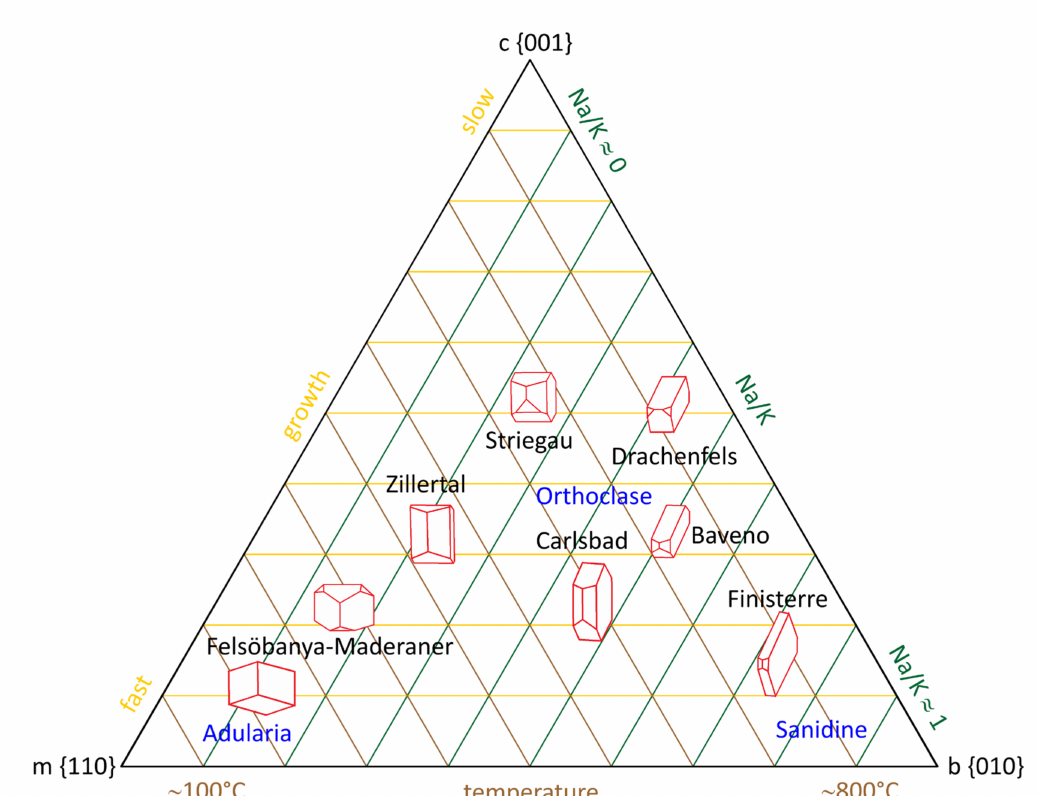
Figure 3. Triangular diagram showing the relative development of crystal faces of alkali feldspars. The significance of the scales is hypothetical, based on face development observations in different feldspars and bibliographical information (see text). Some crystal tracht names after